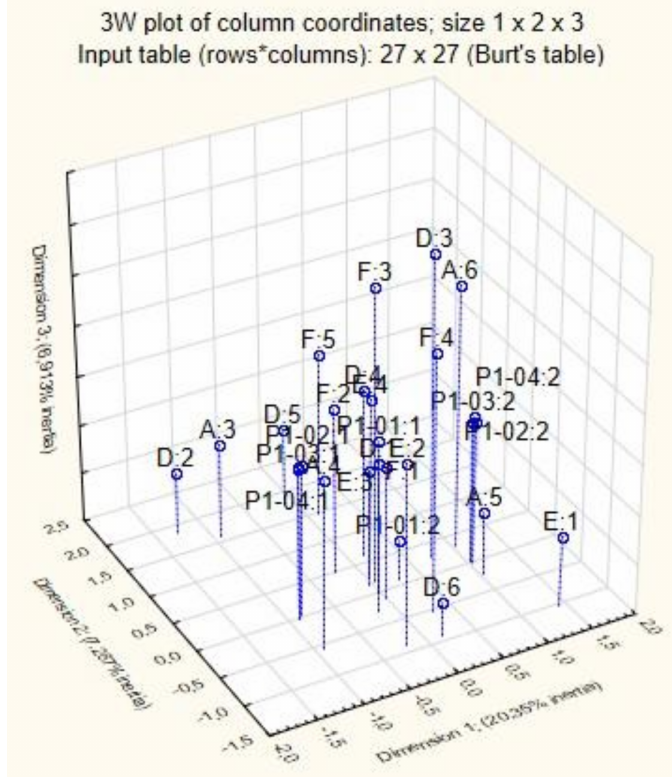
Figure 11. Three-dimensional map of perception.